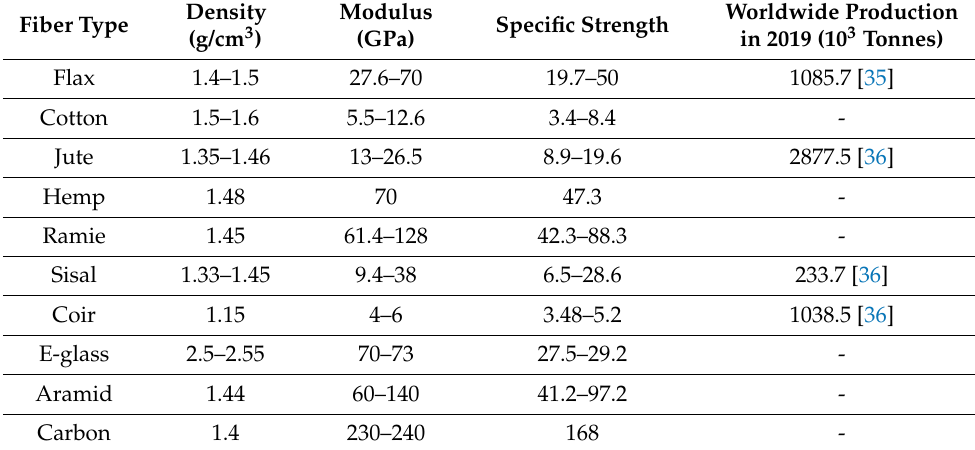
Table 1. Characteristics of fibers